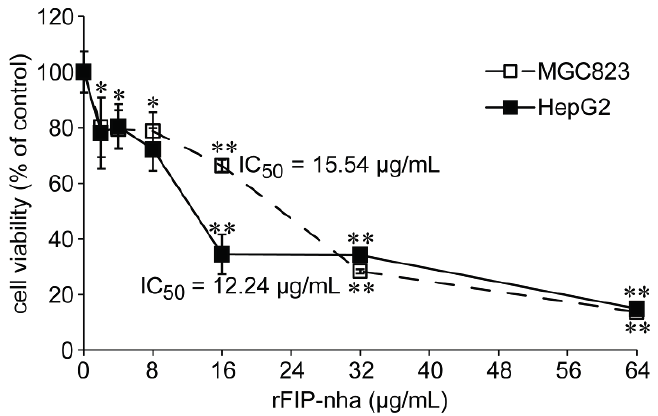
Figure 3. Proliferation inhibitory effects of rFIP-nha on MGC-823 and HepG2 cells measured by MTT assay. Data are presented as mean ± SD ( n = 3). * and ** indicate p < 0.05 and p < 0.01 compared to the negative